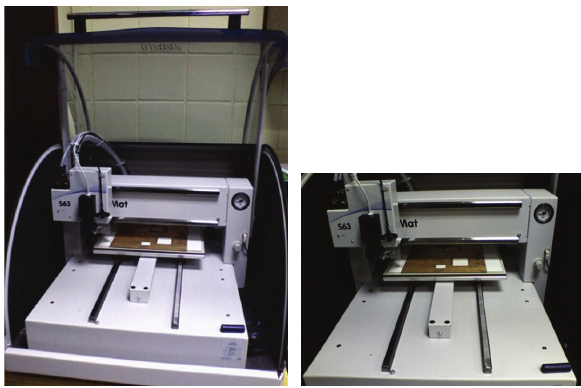
Figure 16: LPKF (S63) PCB prototyping